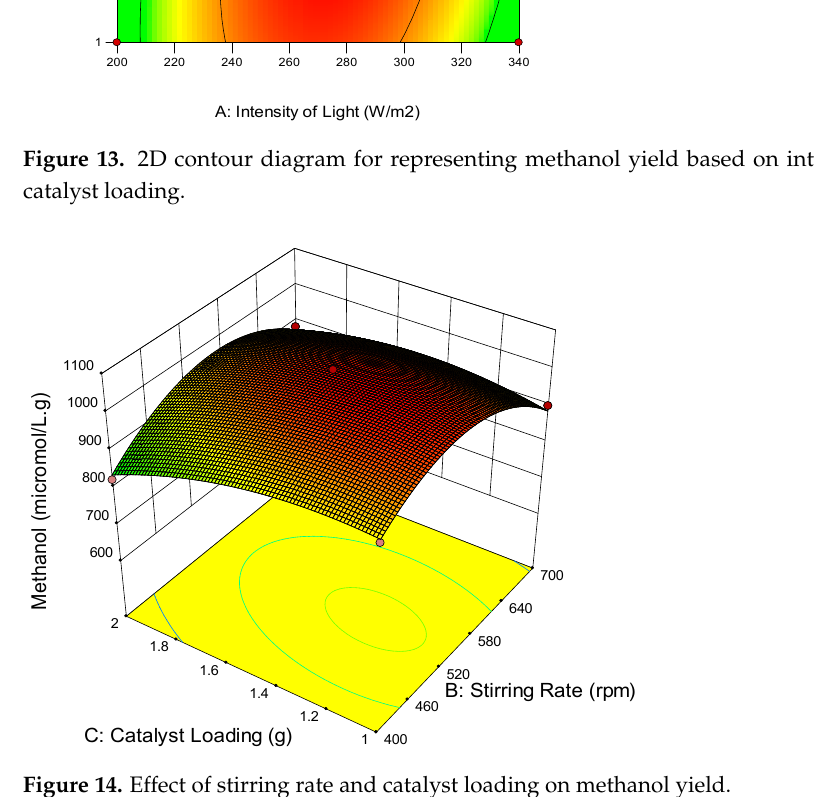
Figure 14. Effect of stirring rate and catalyst loading on methanol yield. Figure 14 . Effect of stirring rate and catalyst loading on methanol yield . Figure 14 . Effect of stirring rate and catalyst loading on methanol yield .